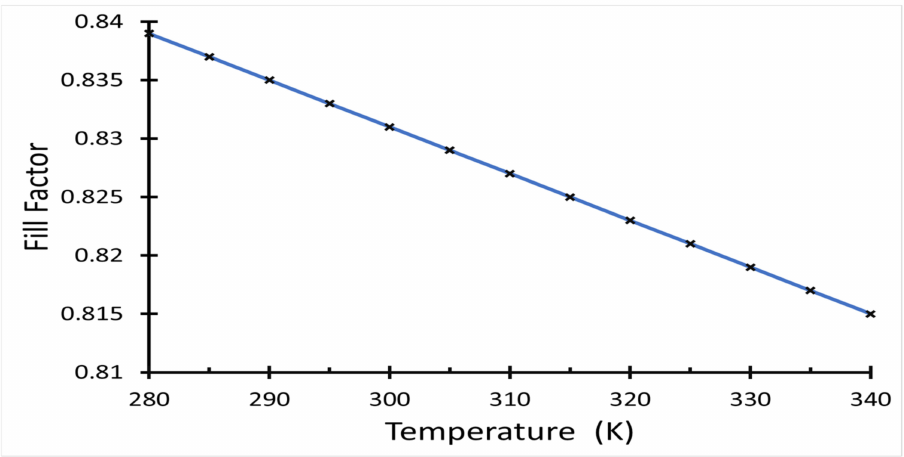
Figure 6. Fill factor of the solar cell as a function of temperature.